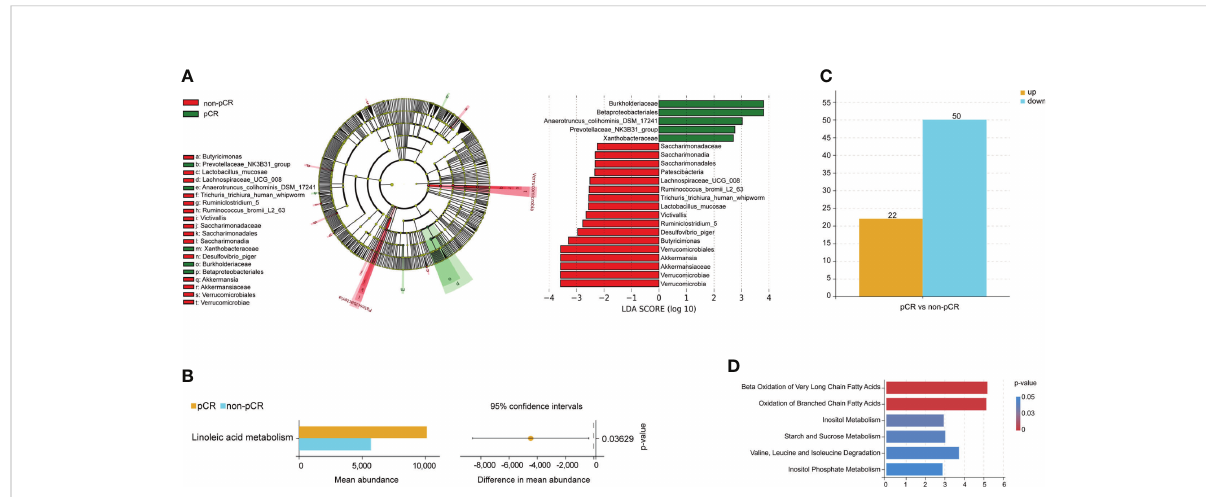
FIGURE 2 Gut microbiome and metabolism characteristics at the baseline associated with neoadjuvant chemoradiotherapy treatment response. (A) Differentially abundant taxa between pCR and non-pCR groups analyzed by LEfSe (Kruskal – Wallis test; p< 0.05; LDA > 2). (B) Differences in KEGG pathway analyses between pCR and non-pCR groups (p< 0.05). (C) The bar plots show upregulated and downregulated metabolites of patients with different nCRT responses. (D) MSEA of metabolites from each patient showed signi fi cantly enriched signaling pathways. nCRT, neoadjuvant chemoradiotherapy; pCR, pathological complete response; LEfSe, linear discriminant analysis (LDA) effect size; KEGG, Kyoto Encyclopedia of Genes and Genome; MSEA, metabolite set enrichment